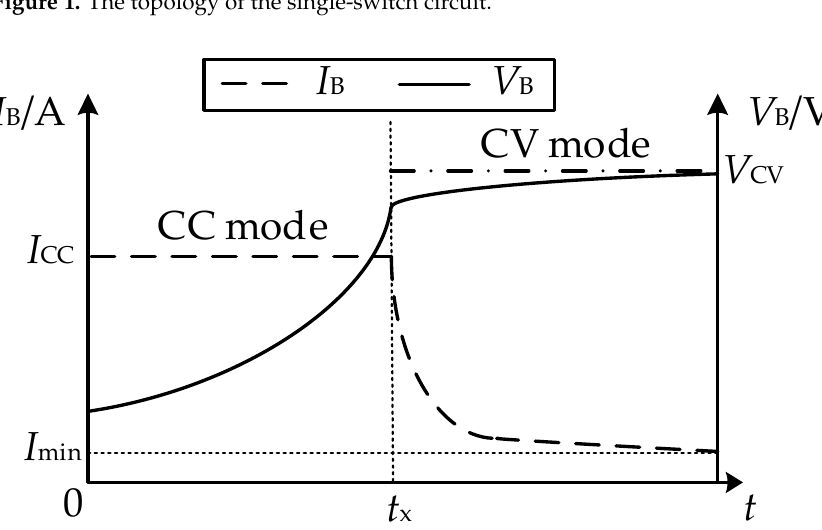
Figure 2. Constant-current and constant-voltage charging curves of a lithium-ion battery.